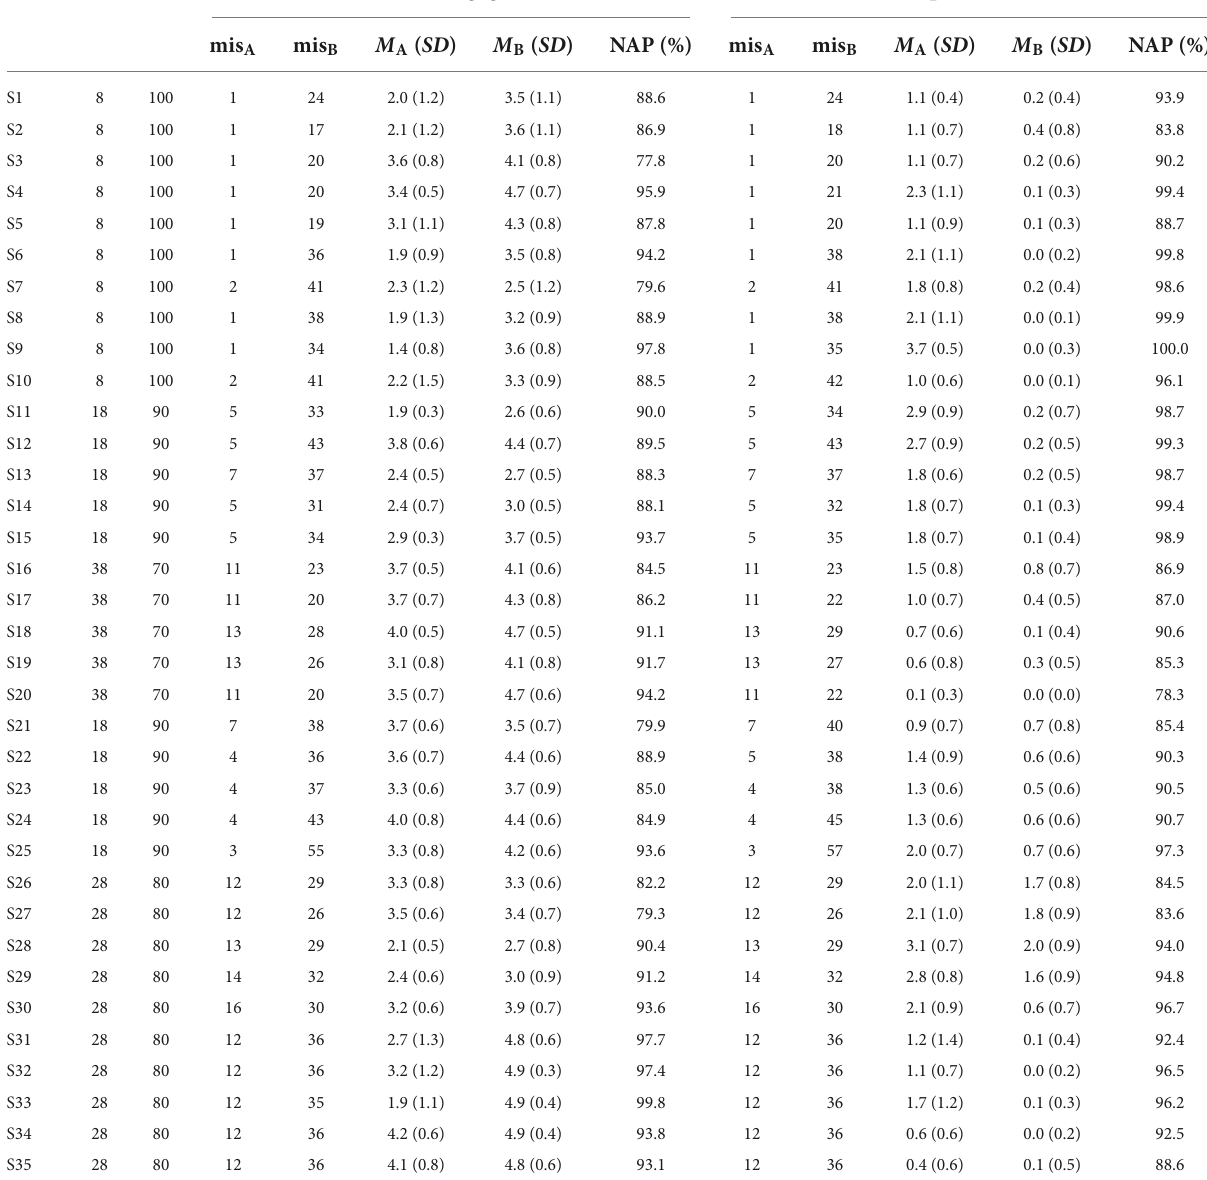
TABLE 3 Descriptive statistics for the 35 single-cases for both dependent